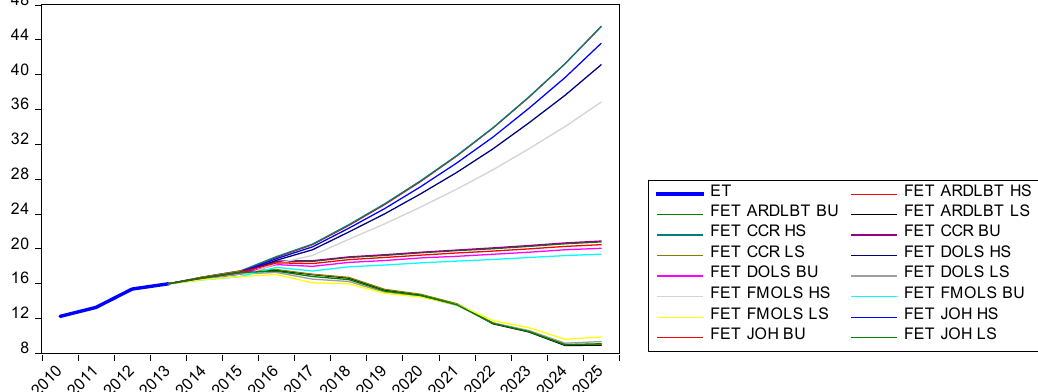
Figure 5. Combined projected time paths of the electricity consumption, TWh. Table 11. Projected electricity consumption, TWh.